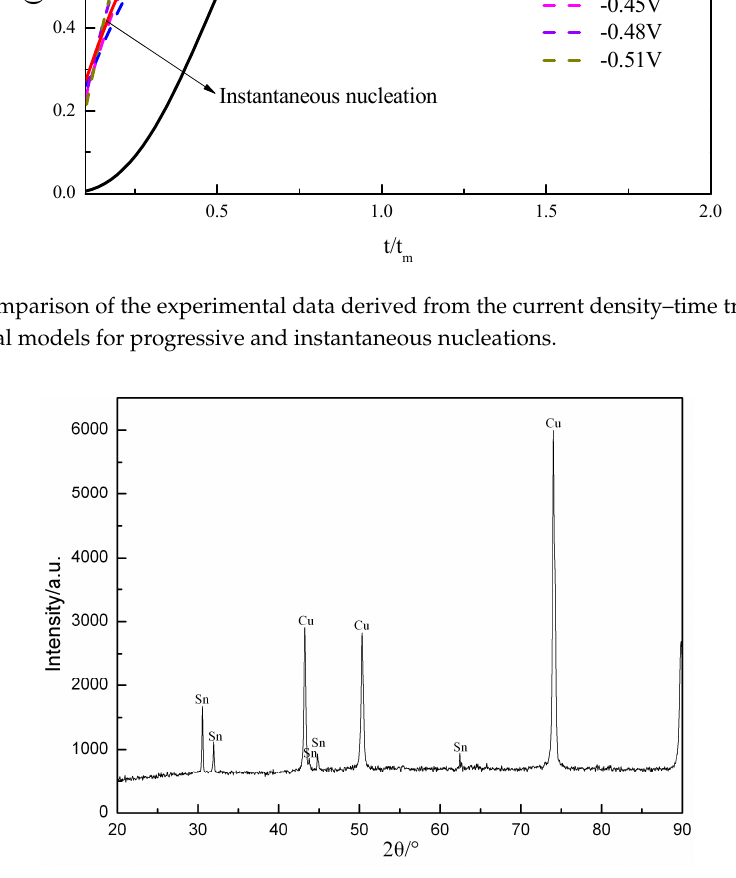
Figure 6. XRD pattern of the Sn electrodeposits obtained from ChCl–urea containing 0.2 M SnCl 2 on a Cu substrate at − 0.6 V and 323 K.